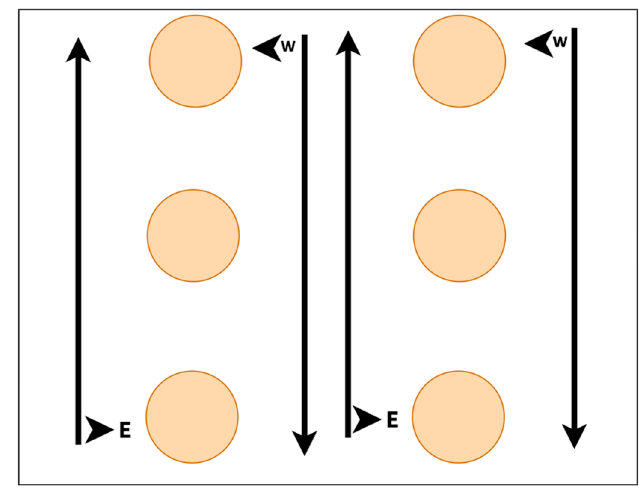
Figure 4. Plot rows showing direction of transect.